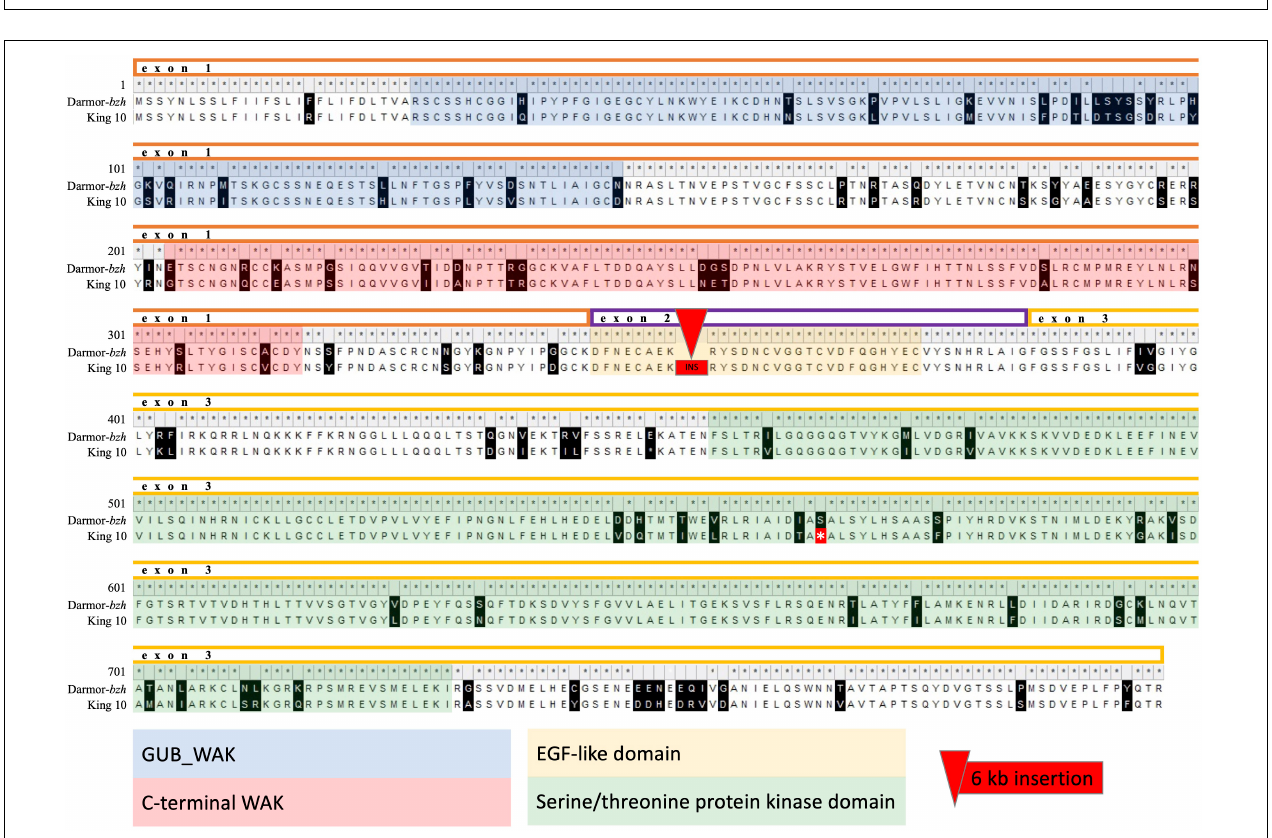
FIGURE 1 | LD based haploblock A07.b304 ( r 2 = 0.4) containing 54 single nucleotide polymorphism (SNP) markers and Rlm9 (A07p27010.1_BnaDAR). Green color indicates the two haplotypes with 24 identical SNP markers between the three parental lines Lorenz, DK Cabernet and JN. Haplotypes 2, 3, and 5 are harboring the 6 kb insertion in the sequence of Rlm9 (orange). Purple bar highlights the overlap with the LD based QTL identified in the diversity set in field trials. Gray highlight indicates Rlm9 gene, yellow highlight indicates SNP markers identified in one individual greenhouse screening round, red color indicates SNP markers identified in at least two individual greenhouse screening rounds.